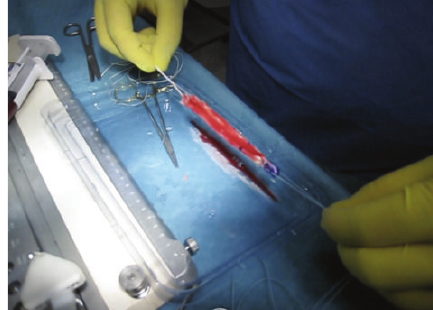
Figure 1: PRPs added between the strands of the graft and left to form a clot before the graft is pulled into the tunnel.